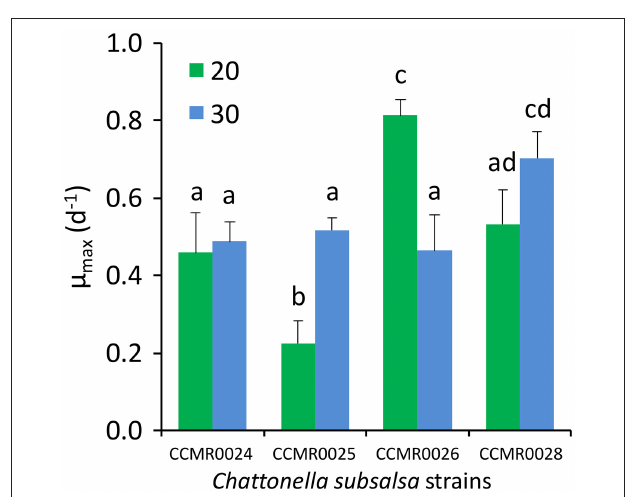
FIGURE 6 | Maximum growth rate of four C. subsalsa strains isolated from Guanabara Bay cultivated in two salinities (20 and 30). Values are average of triplicate cultures for each salinity. Different letters above the bars indicate significant differences in growth rate according to an ANOVA with Tukey’s HSD post-hoc test ( p < 0.05). Whiskers: